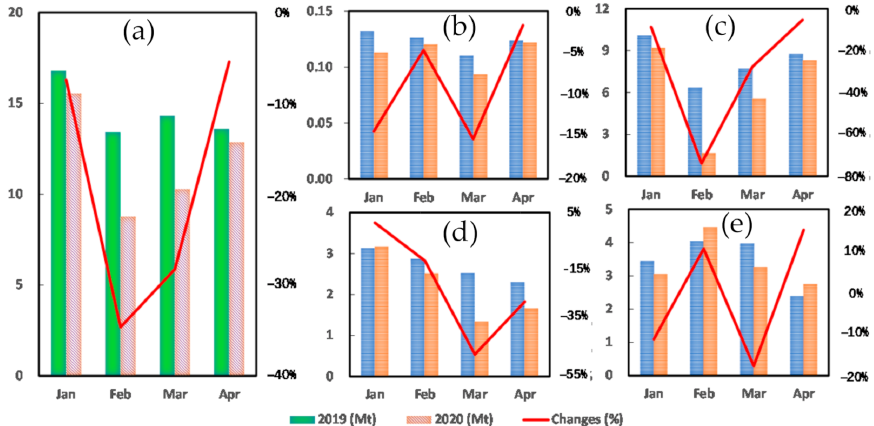
Figure 4. Changes in Hubei consumptive electric power CF from January through April in 2020, compared to the baseline year, 2019. ( a ) Provincial; ( b ) Primary Sector; ( c ) Secondary Sector; ( d ) Tertiary Sector; ( e )